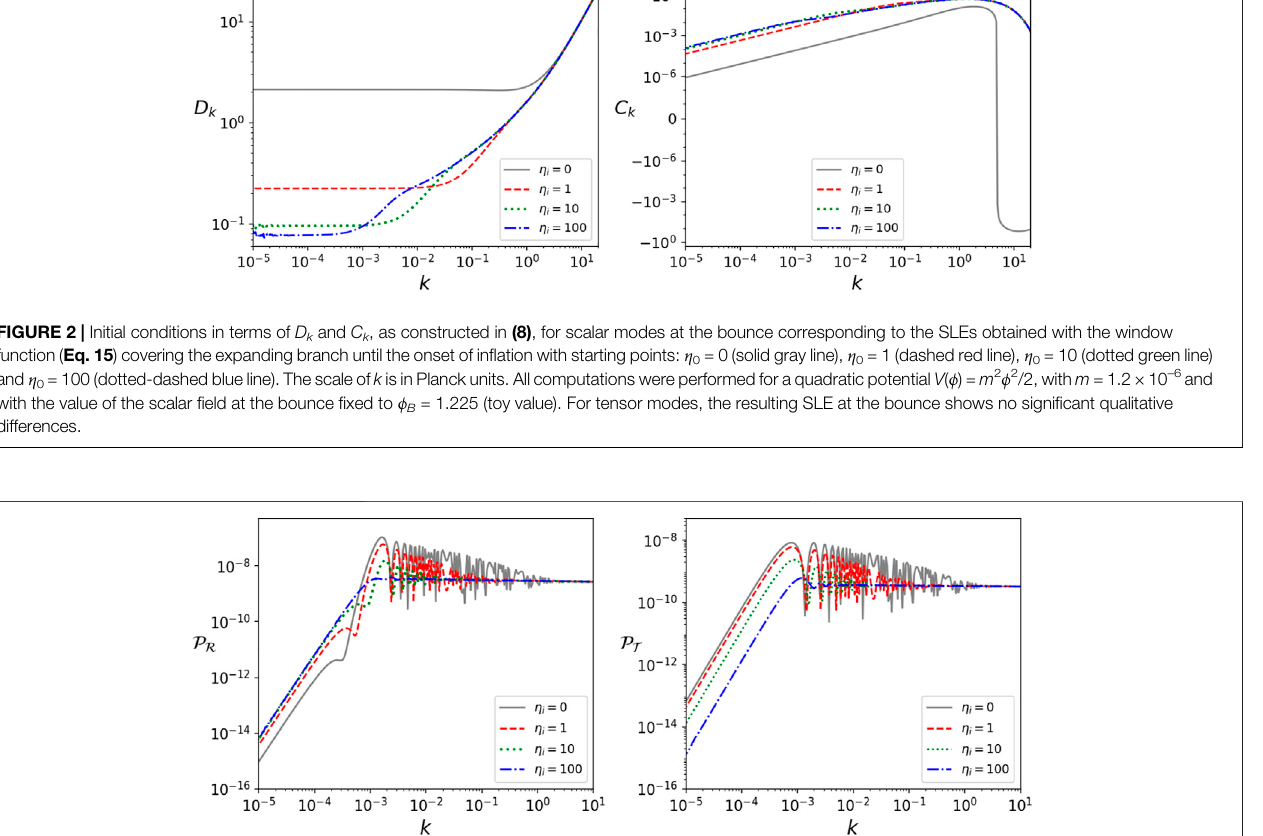
test function is pushed further away from the high curvature regime, the oscillations in the power spectra are gradually dampened. It is interesting to note that, in fact, as Figure 4